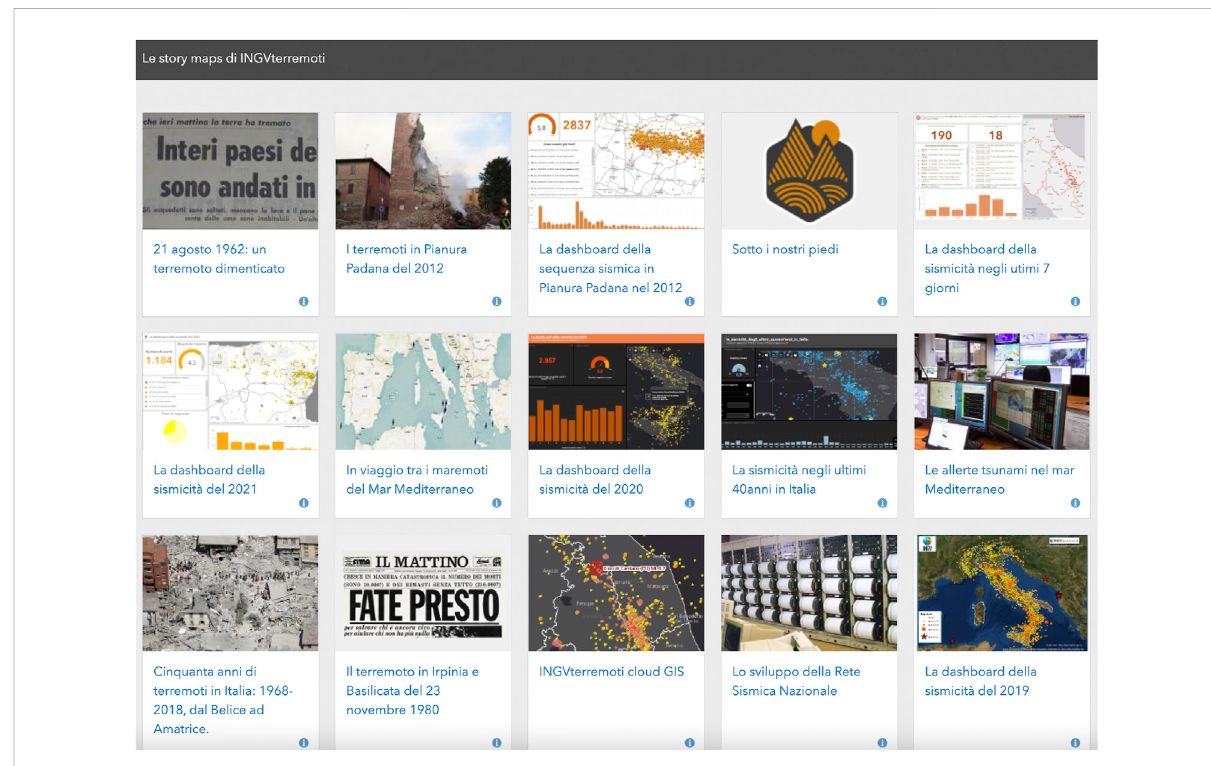
ESRI ArcGIS online gallery with the latest published INGVterremoti story maps and